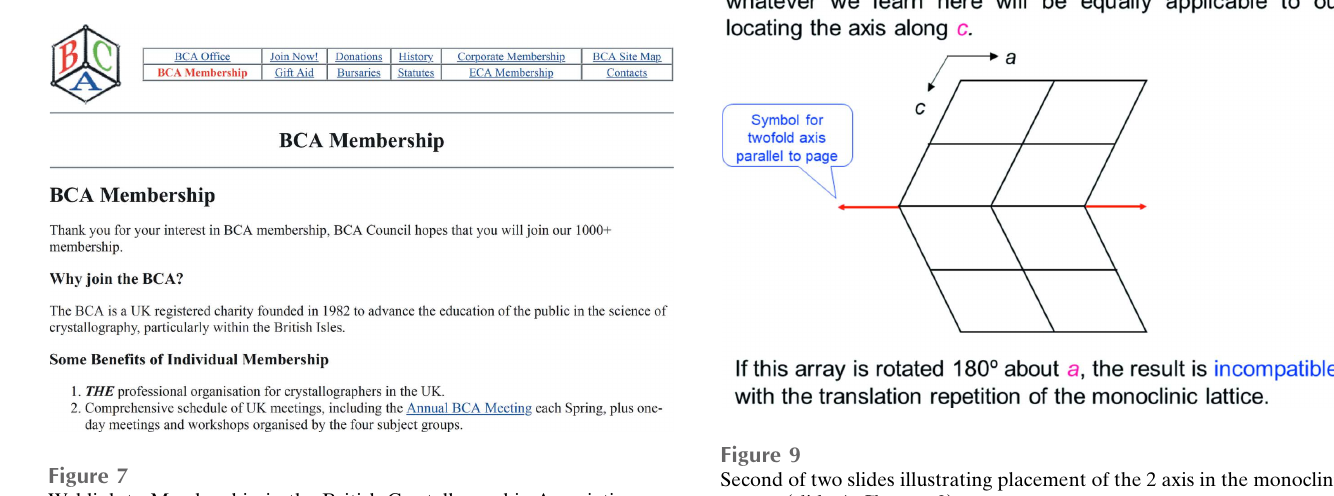
Figure 7 Weblink to Membership in the British Crystallographic Association.